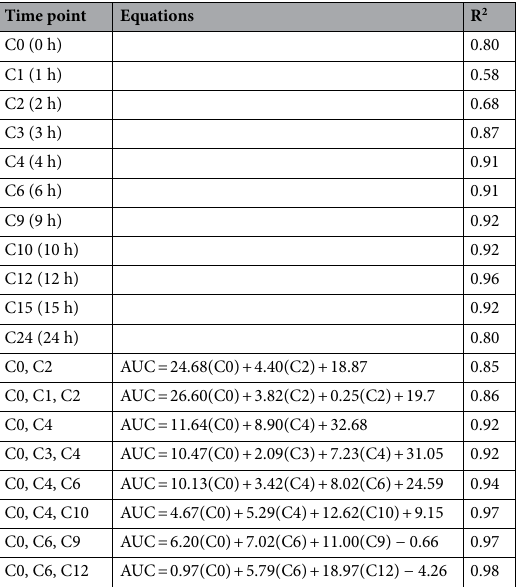
Table 3. The proportion of variance in OD TAC AUC 0-24 is explained by single TAC levels, or combinations of TAC levels at multiple time points.